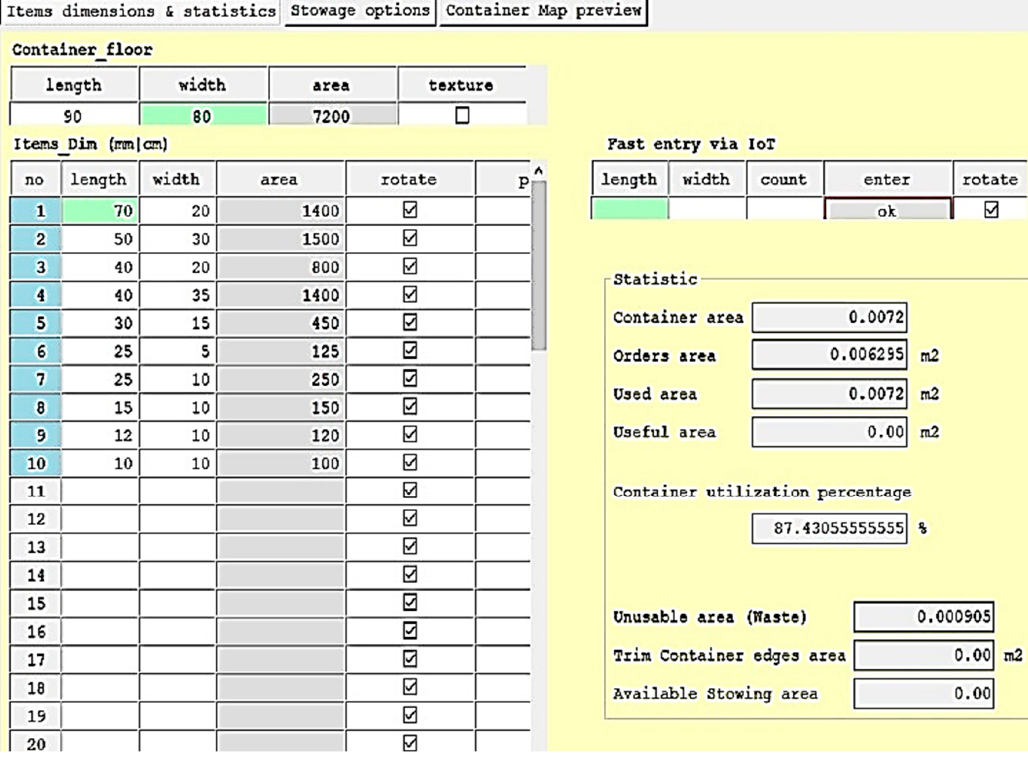
Figure A6. The container utilization by OSM-CA for first station on the distribution path.